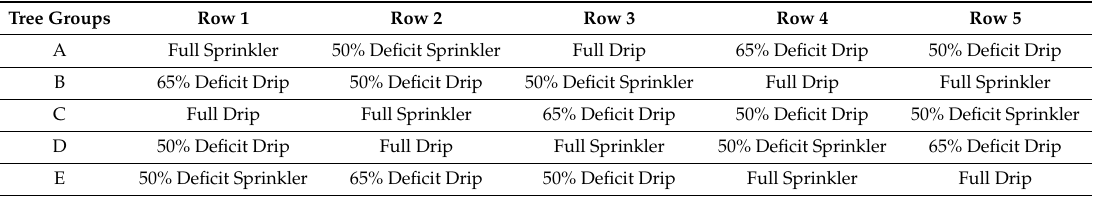
Figure 2. Target orchard showing the five experimental rows. Table 1. Distribution of irrigation methods for the experimental rows.